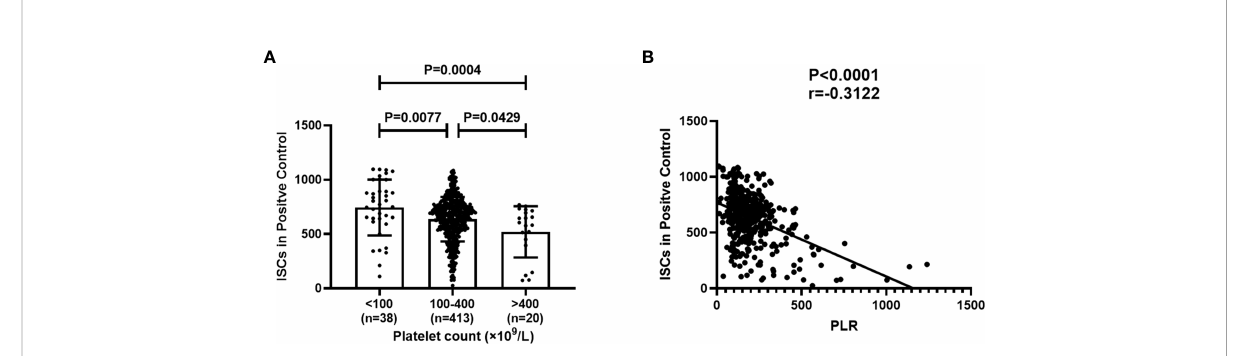
FIGURE 1 Platelet Count and platelet-to-lymphocyte ratio (PLR) correlates with the amount of ISCs in positive control wells of the T-SPOT assay. 471 subjects were divided into three groups according to platelet count and the spot counts in positive control in these three groups were compared. PLR in peripheral blood was counted and the correlation between PLR and the spot counts in positive control was evaluated. (A) Each symbol denotes a single subject, and the mean ± SD for each study population is shown. Statistical signi fi cance was determined by one-way analysis of variance (ANOVA)followed by Tukey ’ s multiple comparisons test. (B) Correlation analysis was performed using Spearman ’ s rho correlations and each symbol denotes a single subject.